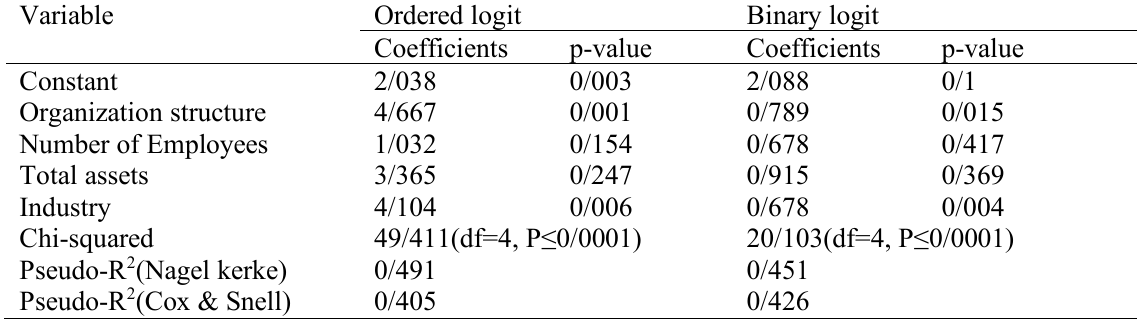
Table 8 . The relationship between organization structure and the stage of PMS development